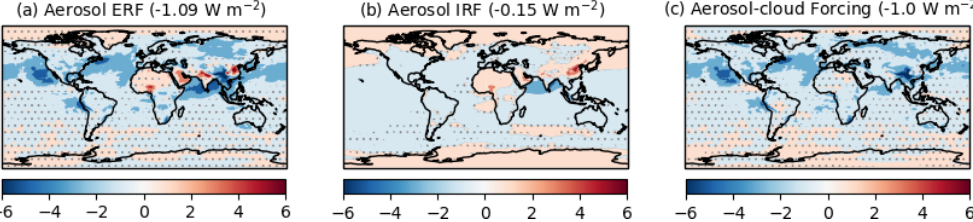
Figure 8. Changes in TOA net radiation from piClim-aer (all anthropogenic aerosols), including (a) the ERF, (b) the IRF, and (c) aerosol– cloud forcing due to ACI and the semi-direct aerosol effect. Global mean values are shown in brackets. Regions where the ERF, IRF, and the aerosol–cloud forcing are outside the 95% confidence level are stippled. Units in Wm − 2